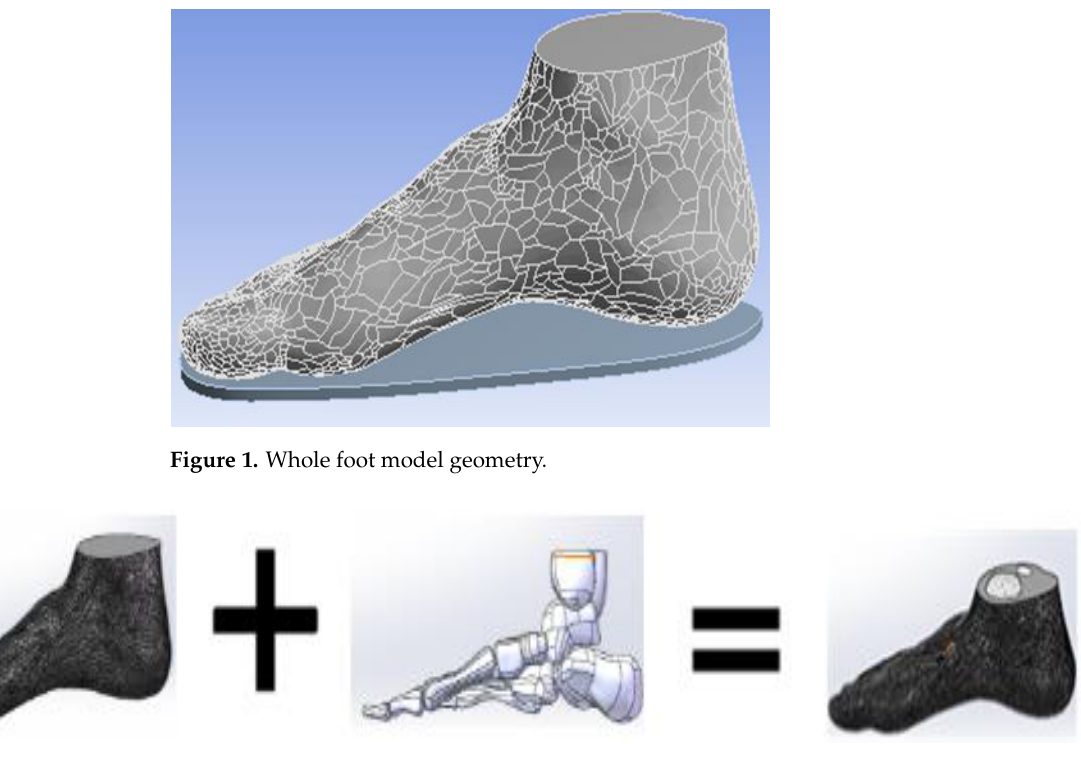
Figure 2. Model construction diagram.